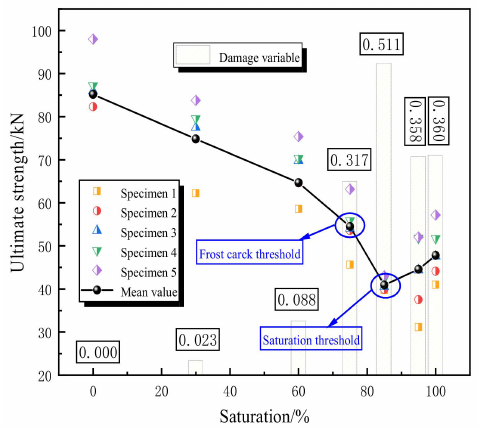
Figure 5. Relationship between peak load and damage variable with